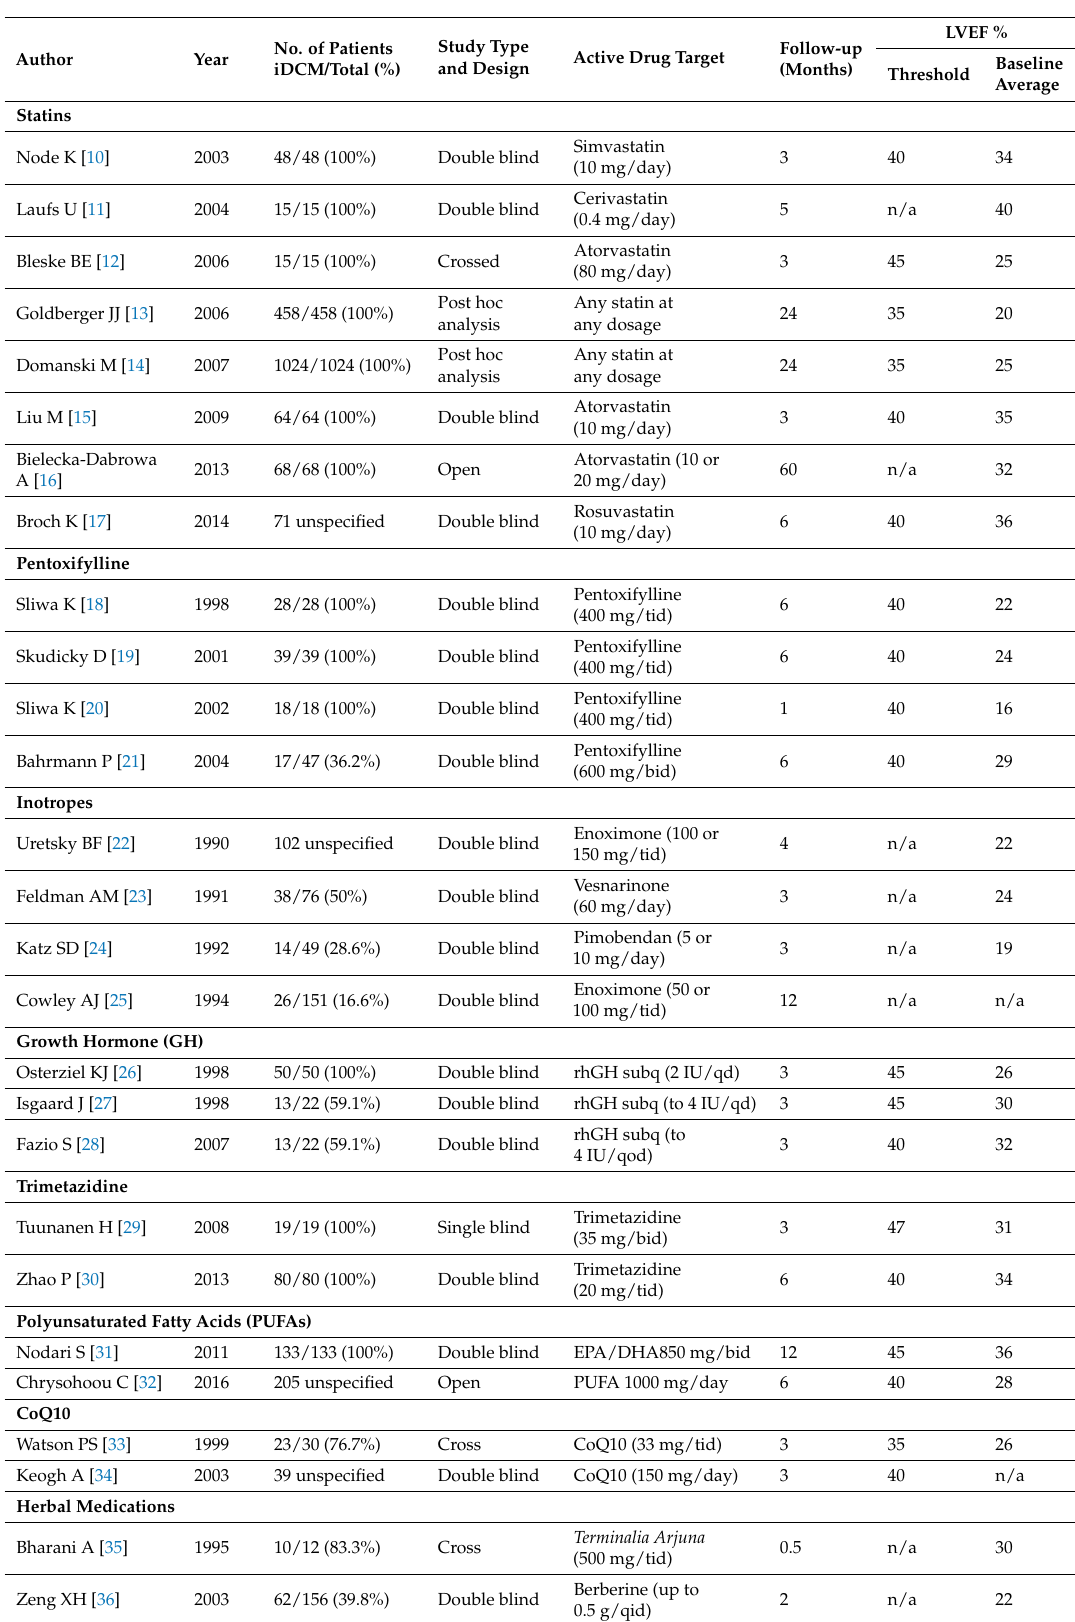
Table 1. Clinical studies targeted for dilated cardiomyopathy pharmacological